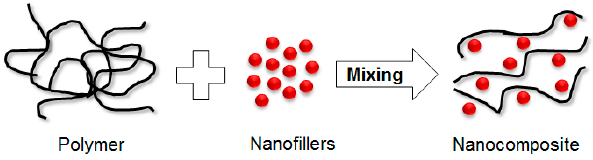
Figure 21. Schematic representation of the mechanical mixing of nanoparticles with the polymer.